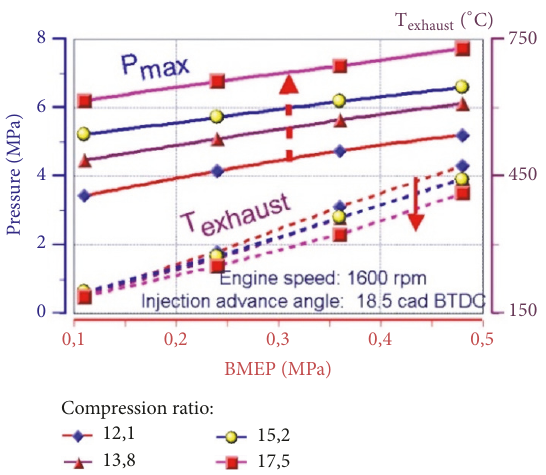
Figure 7: Cylinder pressure and exhaust temperature change in experimental diesel engine.